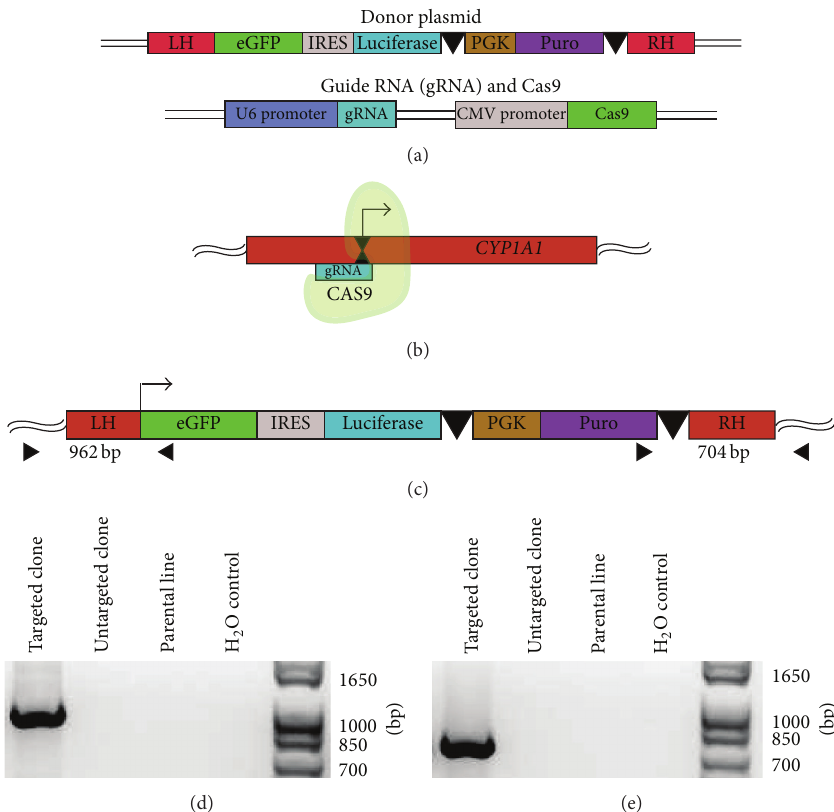
Figure 1: Construction and validation of CYP1A1 reporter iPSCs. (a) Two vectors were created to achieve CAS9 targeted digestion at the CYP1A1 transcription start site and homologous recombination of a reporter construct. The donor plasmid contains a cassette that includes eGFP and luciferase separated by an internal ribosome entry sequence (IRES). Directly downstream of these reporter elements is a puromycin resistance gene (Puro) driven by a constitutive promoter (PGK) and flanked by loxP sites (denoted by black arrowheads). This cassette is flanked by regions that are homologous to the CYP1A1 endogenous locus (Left Homology, LH; Right Homology, RH) to facilitate homologous recombination. The guide RNA (gRNA) and Cas9 were encoded on the same plasmid, each driven by a separate constitutive promoter (U6 and CMV, resp.). (b) An idealized schematic of Cas9 digestion at the transcription start site (denoted by black arrow) of the CYP1A1 locus. (c) The integrated reporter construct is expected to specifically target the transcription start site of CYP1A1 , and a PCR strategy was employed that creates amplicons in the 5 󸀠 and 3 󸀠 flanking regions of the cassette that include elements from the reporter construct as well as endogenous regions that are not encoded by the donor plasmid. (d) The 5 󸀠 amplicon (expected size = 962 bp) was exclusively detected in a properly targeted iPSC clone. (e) The 3 󸀠 amplicon (expected size = 704bp) also could not be amplified in untargeted clones or the parental iPSC line but was detected in a properly targeted iPSC